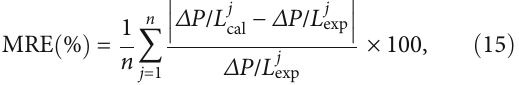
) under 11 kinds g